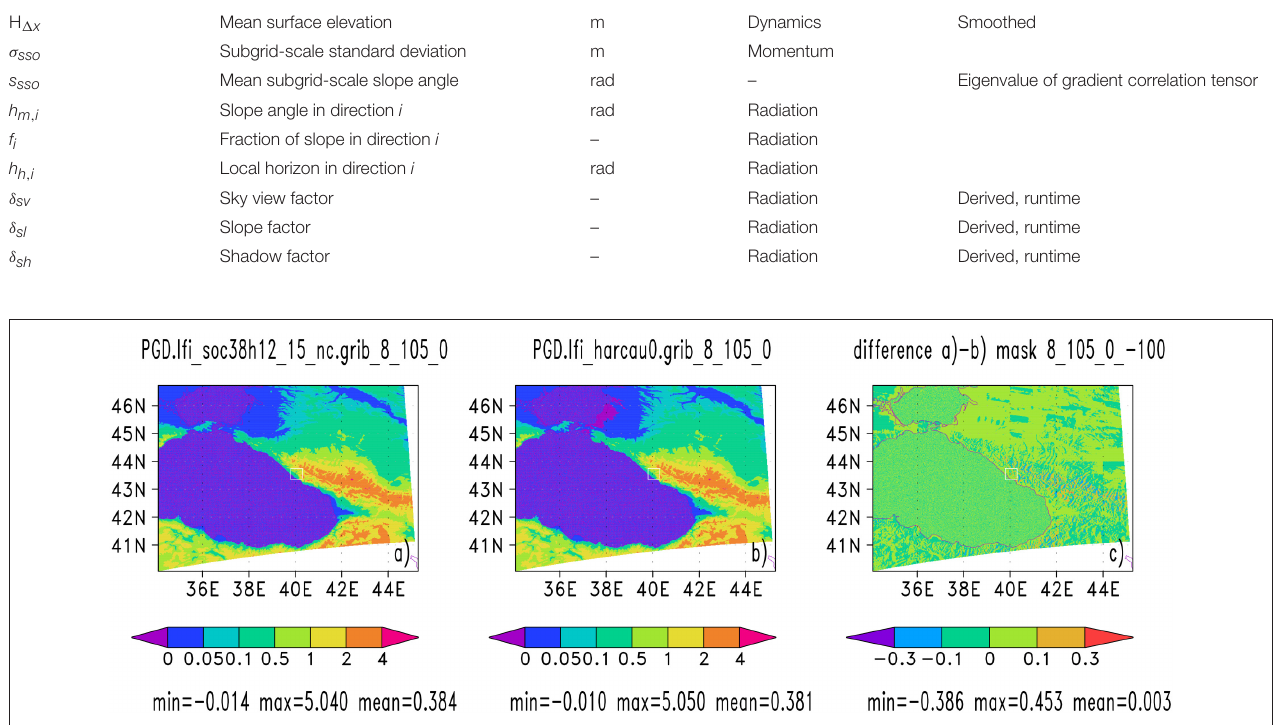
FIGURE 2 | Average grid-scale elevation (km) for experiments with 1500m resolution, based on (A) GTOPO30 and (B) SRTM 3 ′′ data, (C) their difference. Color scales are given in the legend. The small white box indicates the location of Olympic venue, see Figure 5 for detailed orography contours